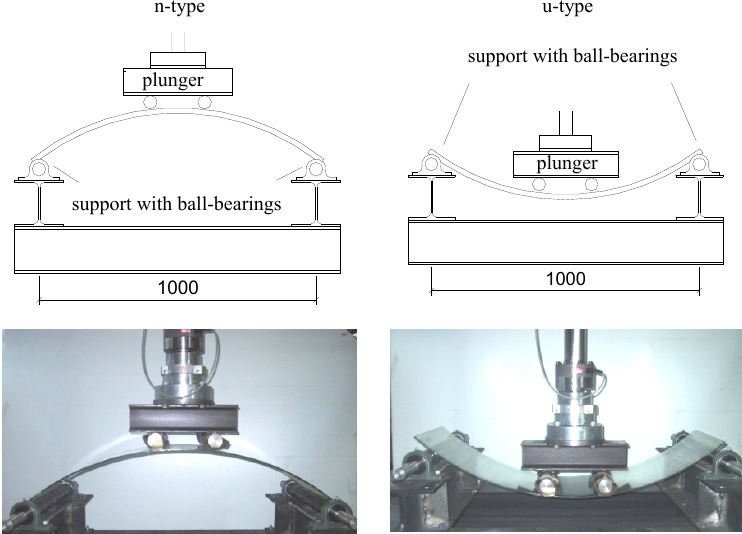
Figure 4a and b: Modified Four-Point-Bending test set-up for curved glass panels (“n”- and